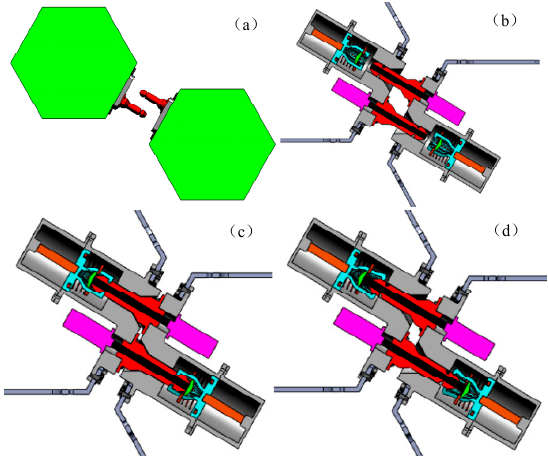
Figure 5. Operation principle of SMALL: (a) capture, (b) positioning, (c) locking & adjustment, (d) separation.